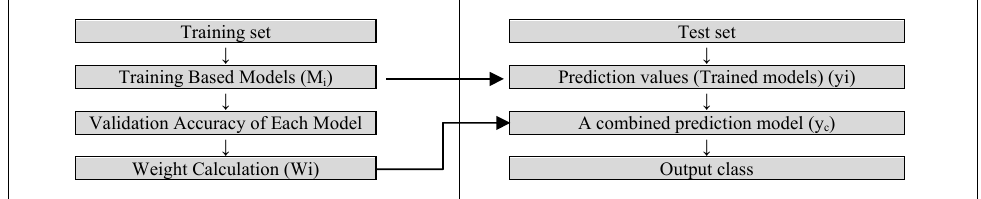
Fig. 1. The proposed